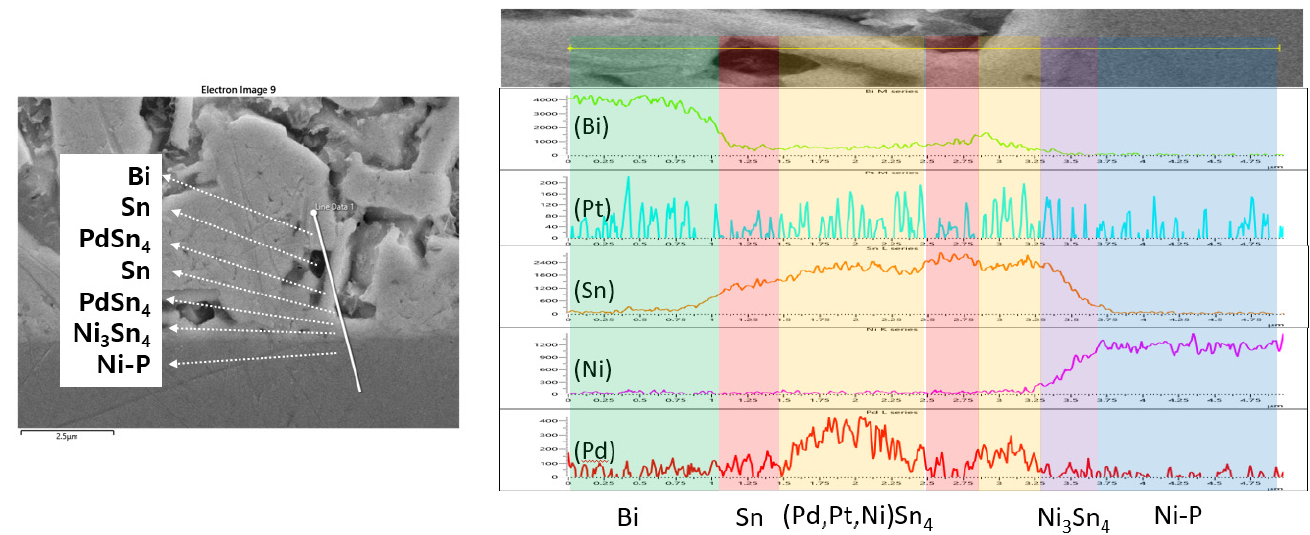
Figure 5. Interfacial microstructures of the Sn-58Bi-xPt/ENEPIG solder joints. (scale bars: 2 μ m).